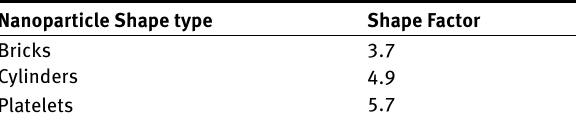
Table 1: Nanoparticle shape and shape factor Nanoparticle Shape